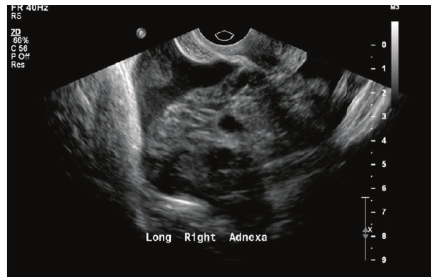
Figure 4: Pelvic ultrasound (long view, right adnexa) demonstrates a fluid collection of mixed echogenic and anechoic material sur- rounding the right ovary.